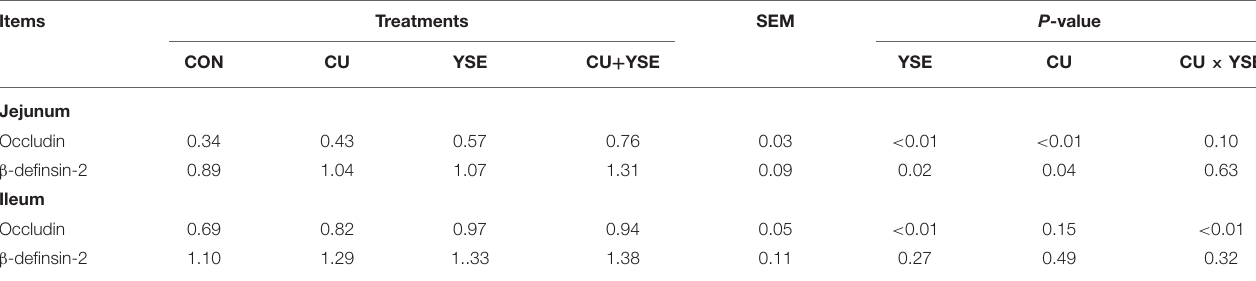
FIGURE 2 | The effect of dietary YSE and oral CU on level of intestinal mucosa β -definsin-2 and occludin concentrations. Piglets fed basal diet and orally administered 1mL of 0.85% saline (CON); piglets fed basal diet and orally administered 1mL 1 × 10 9 cfu/mL C. utilis in 0.85% saline (CU); piglets fed the basal diet containing YSE (120 mg/kg) and orally administered 1mL of 0.85% saline (YSE); Piglets fed the basal diet containing 120 mg/kg YSE and 1mL 1 × 10 9 cfu/mL C. utilis in 0.85% saline (YSE + CU). TABLE 7 | Effects of dietary YSE and oral CU on level of intestinal mucosa β -definsin-2 and occludin concentration.